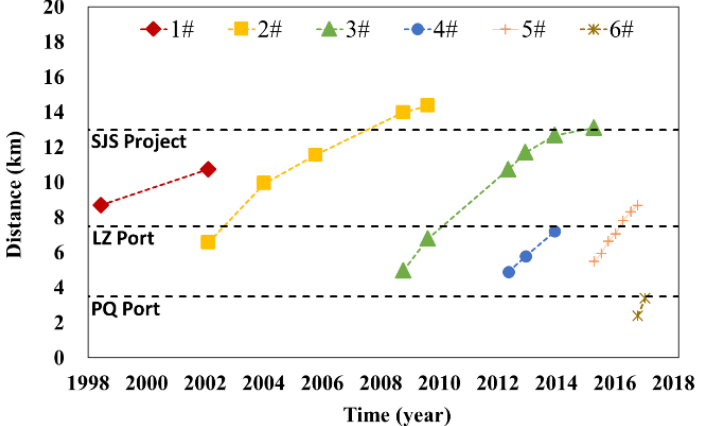
Figure 5. Migration tracks of the detached bars, including two complete cycle, three splitting cycle and one unfinished cycle.